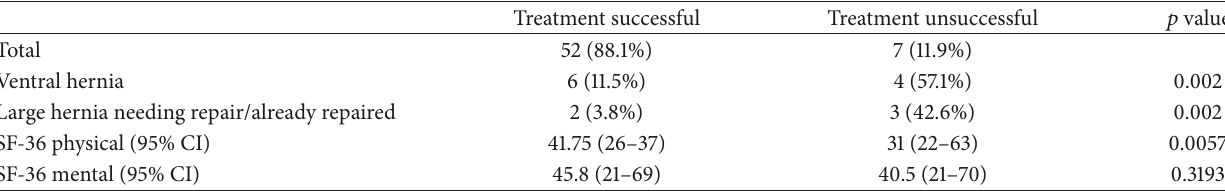
Table 3: Results from the three-month follow-up clinical examination and the quality of life questionnaire. The results are given as number 𝑁 (%). For the SF-36, the results given are mean value and confidence interval (95%